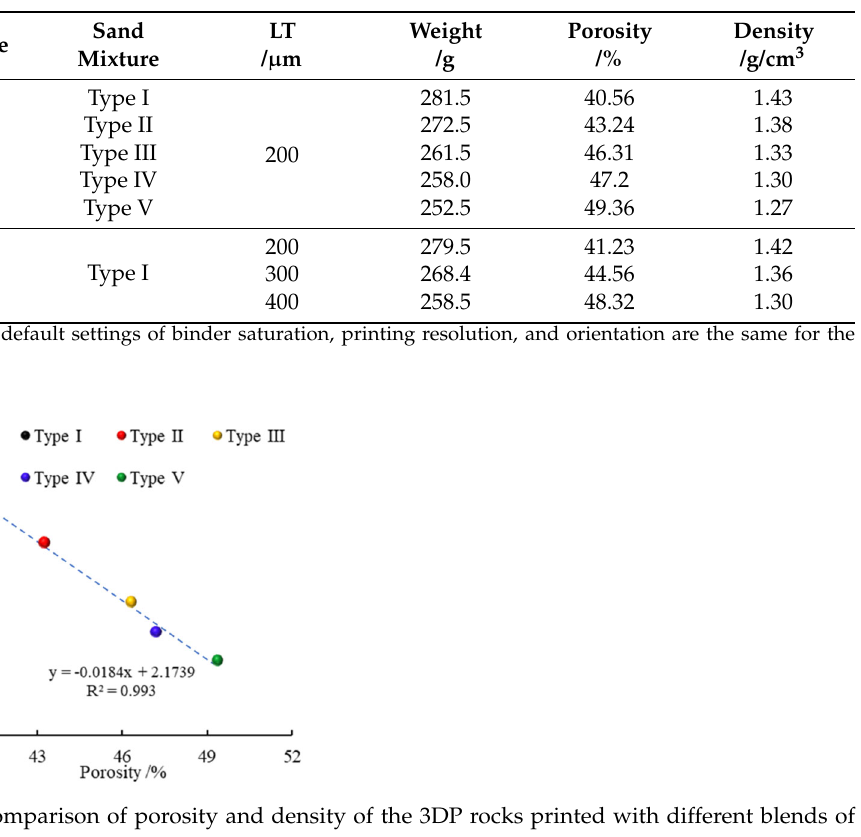
Table 2. Porosity and density of the 3DP rocks.